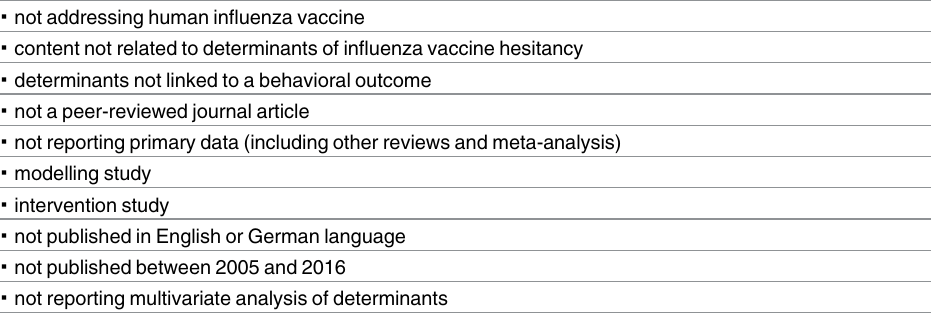
Table 2. Exclusion criteria used in selection process for literature review on influenza vaccine